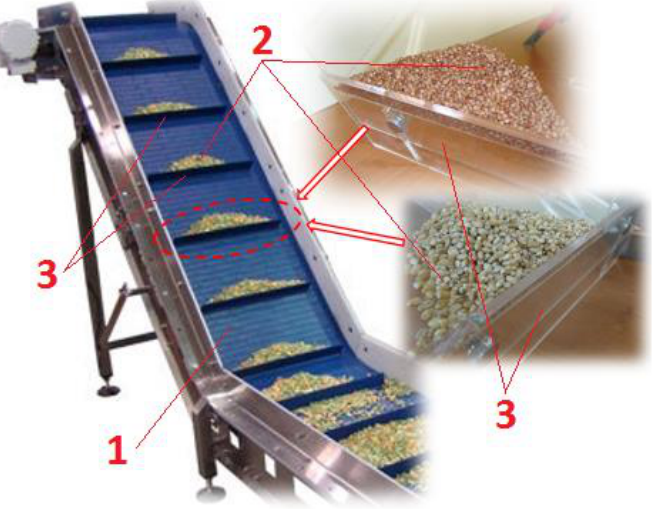
Figure 1. Conveyor with conveyor belt with belt cleats. 1 — conveyor belt, 2 — batch of transported material, 3 — belt cleat